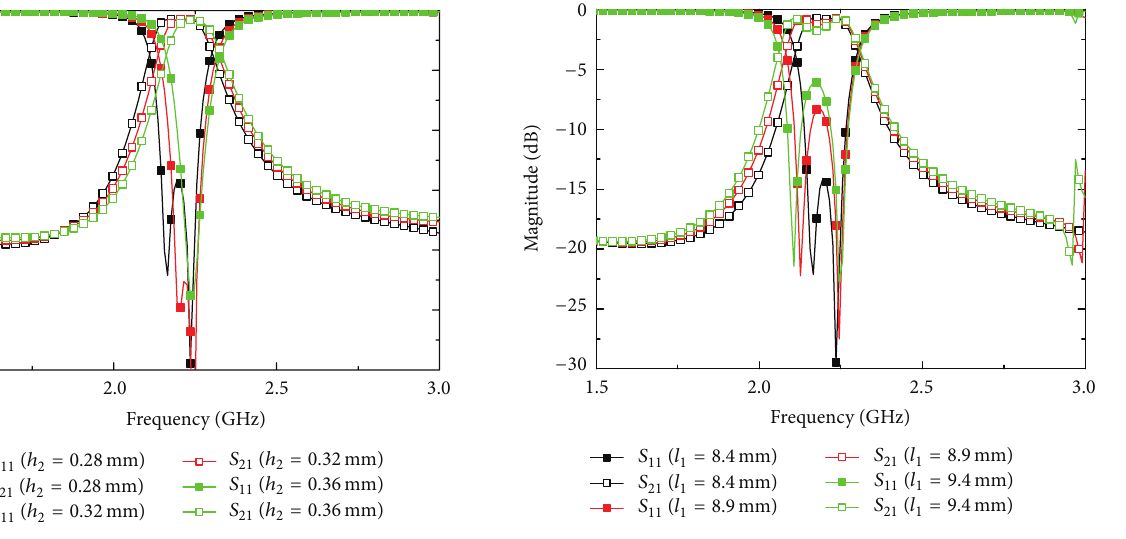
Figure 4: Simulated frequency response relative to changes in the height ℎ 2 .